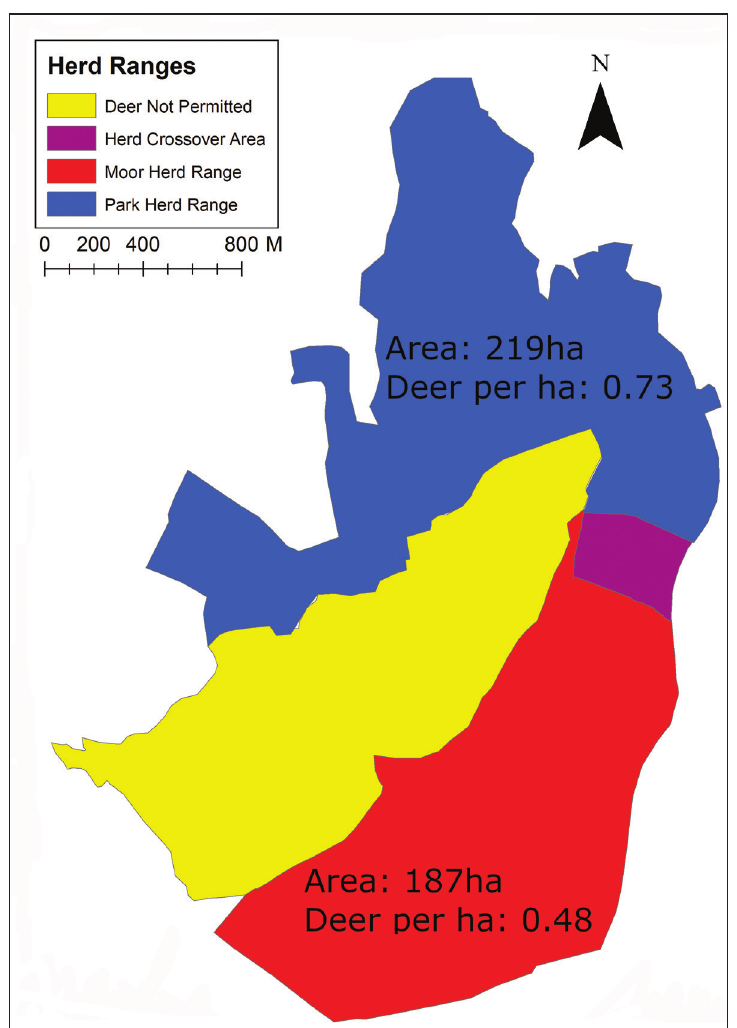
Figure 2. Map showing the area open to each of the herds. The herd crossover area (area accessible to both herds) is included in the total area of both herds. Area where deer are excluded also shown. Data collected from Lyme Park, Disley, UK, in